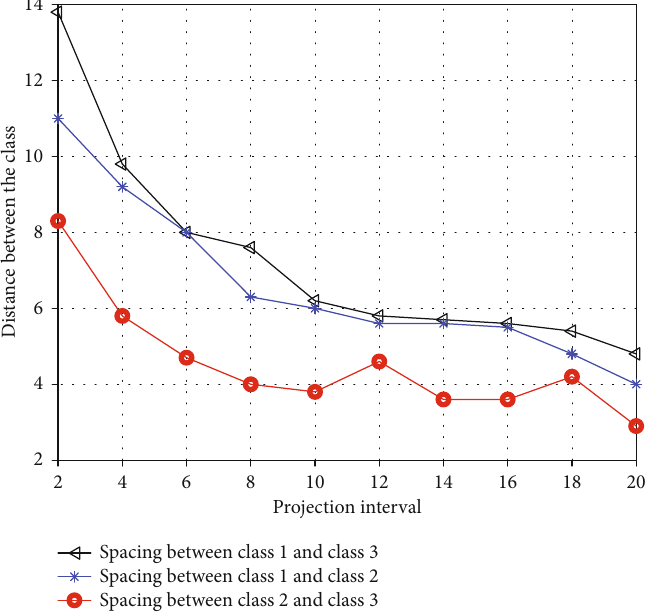
Figure 6: Relation curve between projective interval and interclass